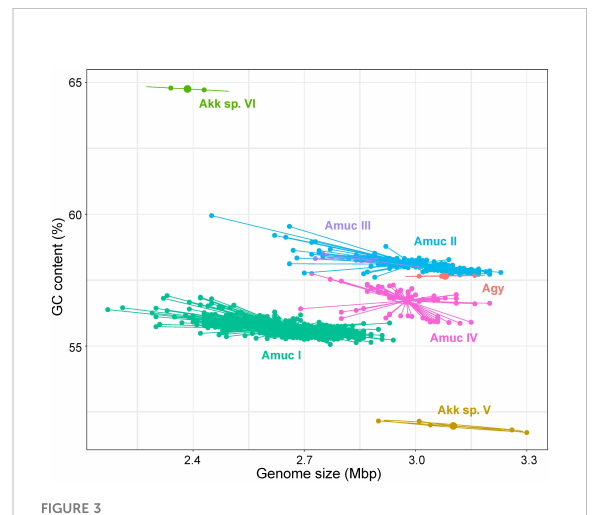
FIGURE 3 Scatter plot of the genome size and GC content of seven Akkermansia species and